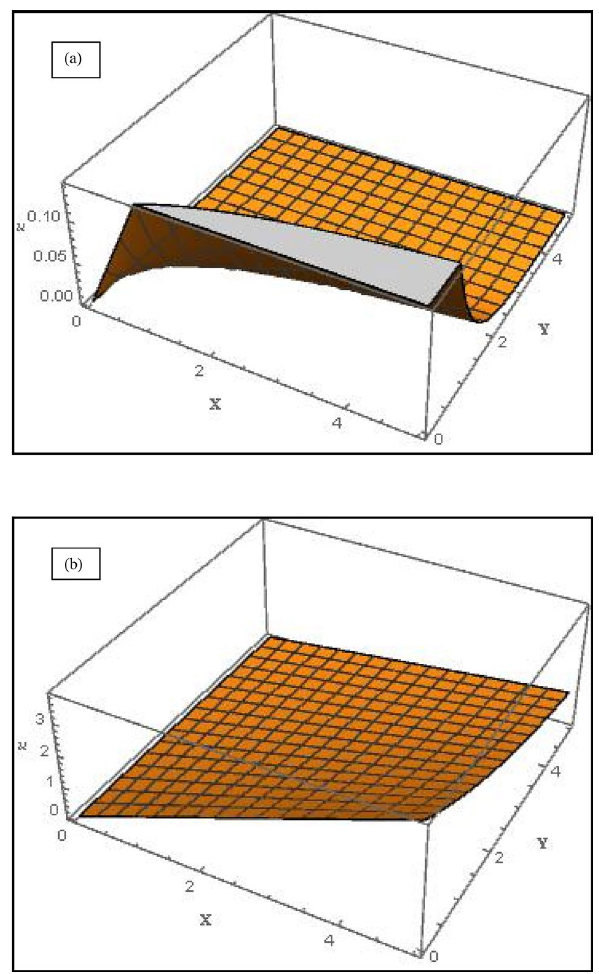
Figure 6. 3-D graph of velocity profile along x -direction for ( a ) suction case ( V C = 1 ) and ( b ) injection case ( V C = − 1 ) with M = Da − 1 = (cid:31) = 1 , S 1 = 1, S 2 = − 1 , ϕ 1 = 0.1, ϕ 2 = 0.04